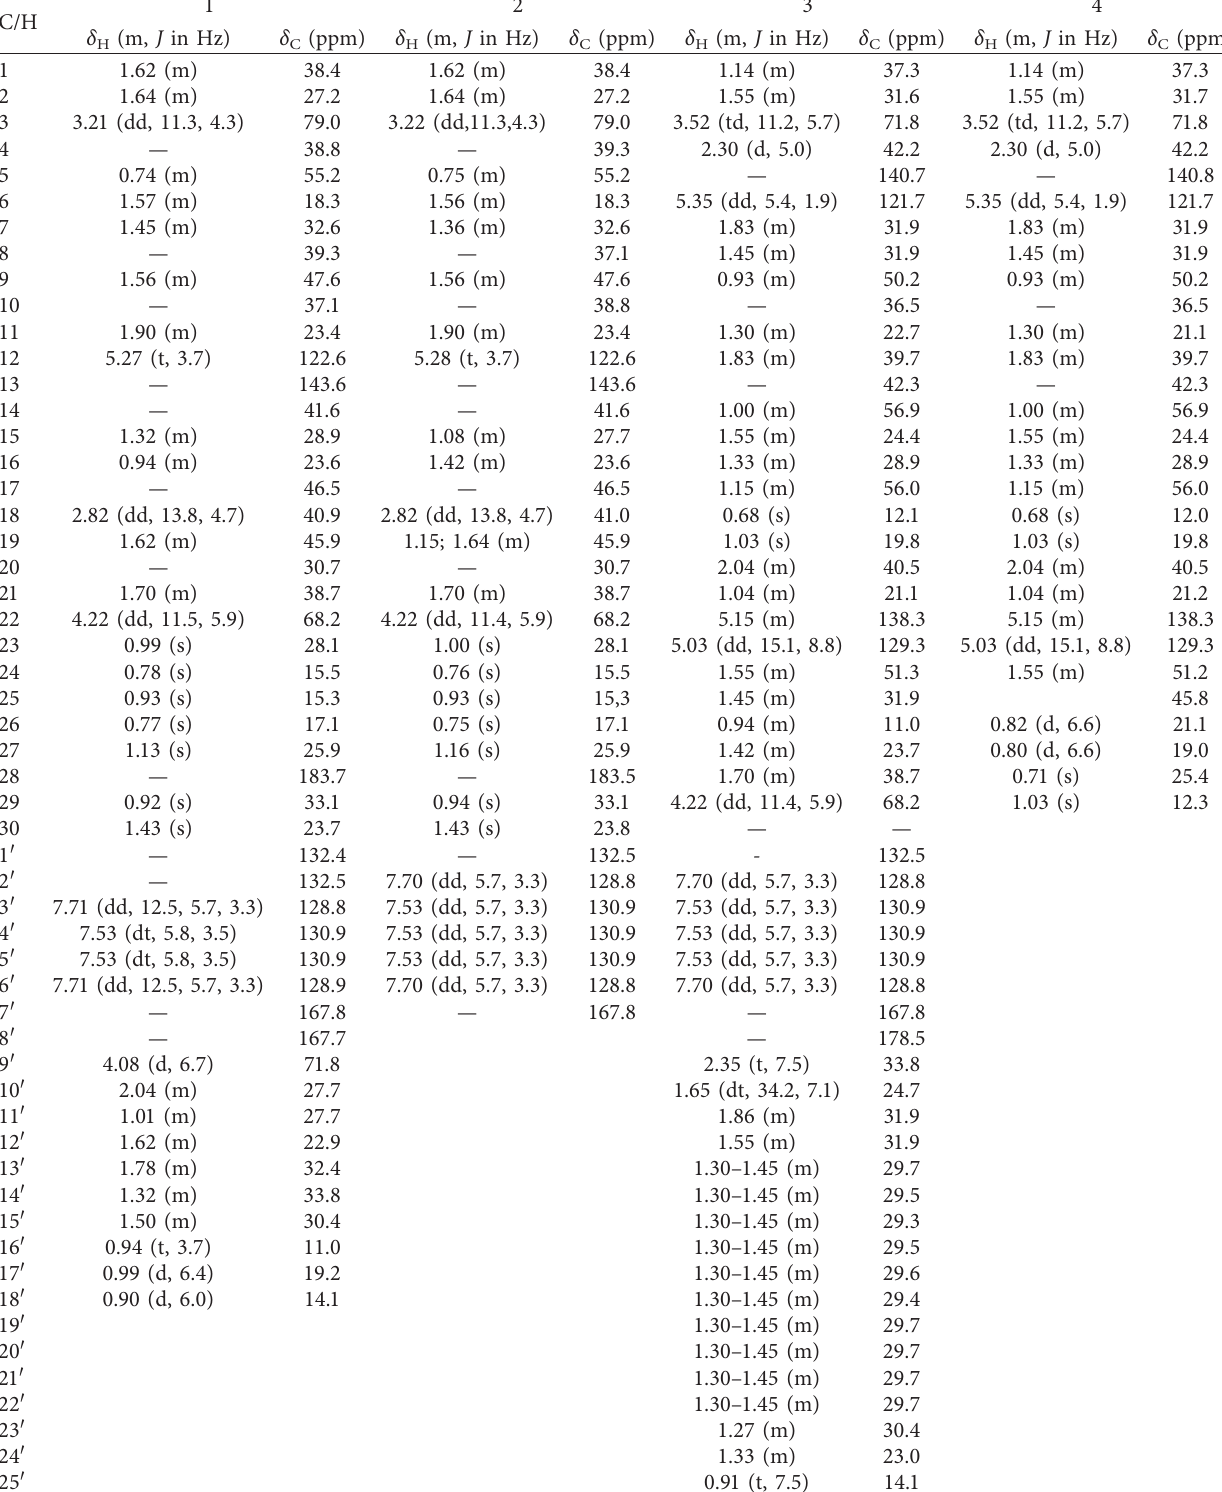
Table 1: 1 H NMR and 13 C NMR (600 MHz) spectroscopic data for compounds 1 – 4 in CDCl